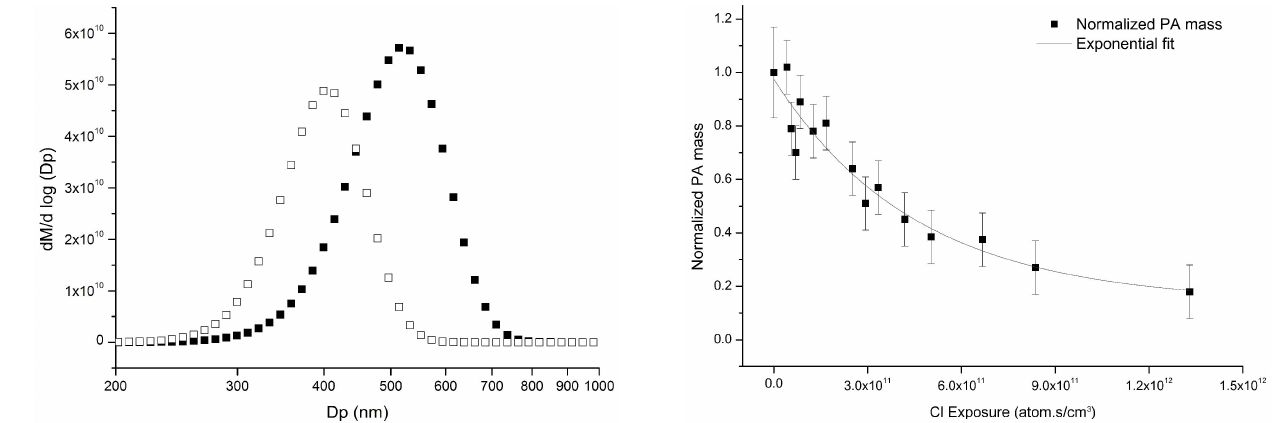
Figure 5. Normalized mass of PA remaining in the particles as a function of the chlorine 2 Fig. 5. Normalized mass of PA remaining in the particles as a func- exposure in the presence of oxygen (squares) and the corresponding exponential fit (solid 3 tion of the chlorine exposure in the presence of oxygen (squares) line). 4 and the corresponding exponential fit (solid The products identification has been performed after the derivatization step by collecting the 6 particles at the AFT outlet during 30 minutes (see Fig. 6). We were not able to identify any 7 products on non-derivatized samples. 8 The main identified products are dicarboxylic and oxocarboxylic acids and confirm the 9 observations by McNeill (McNeill et al., 2008) where oxocarboxylic acids were detected. 10